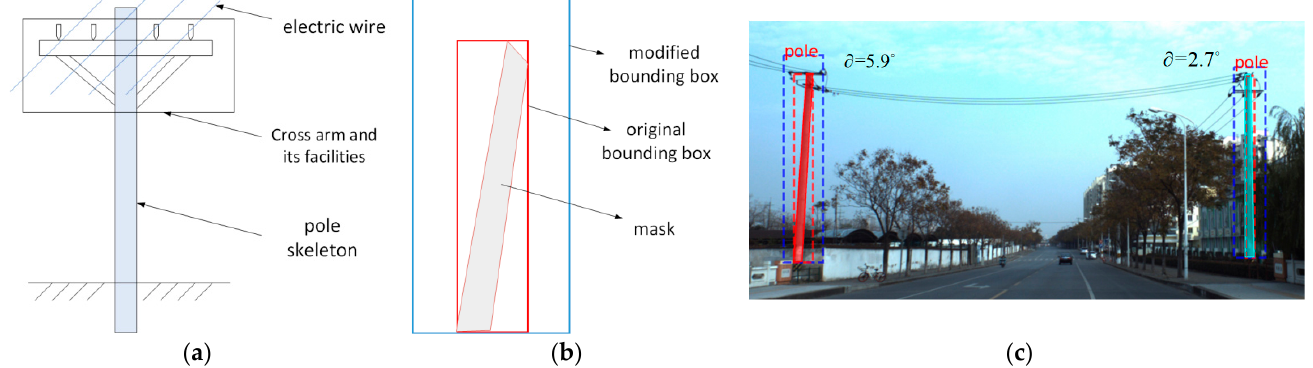
Figure 2. Network structure of the improved Mask R-CNN.